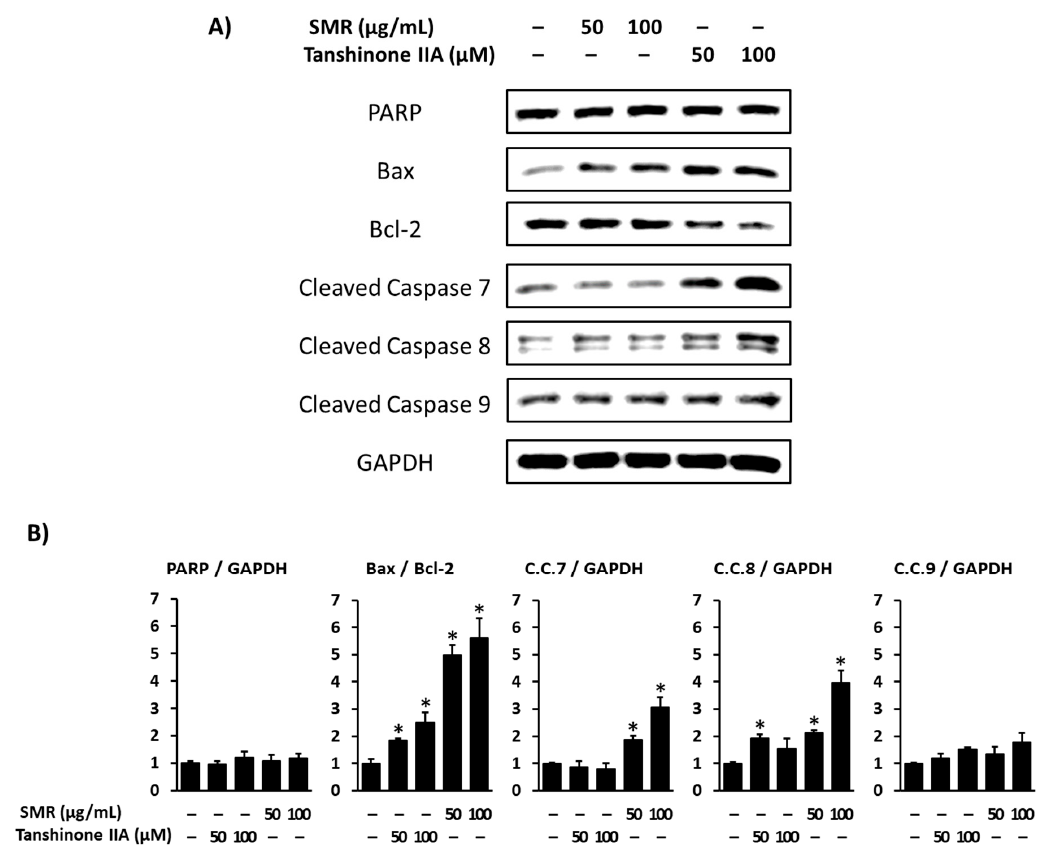
Figure 4. Effects of 70% ethanol extract of Salviae Miltiorrhizae Radix (SMR) and tanshinone IIA on apoptosis in HCT ‐ 116 cells. ( A ) Protein expression of PARP, Bax, Bcl ‐ 2, cleaved caspase ‐ 7, cleaved caspase ‐ 8, cleaved caspase ‐ 9, and GAPDH. ( B ) Graph of relative protein expression. Data are the means of experiments performed in triplicate. Data are presented as the mean ± SD. and were analyzed using the Student’s t ‐ test. * p < 0.05 versus non ‐ treated cells.